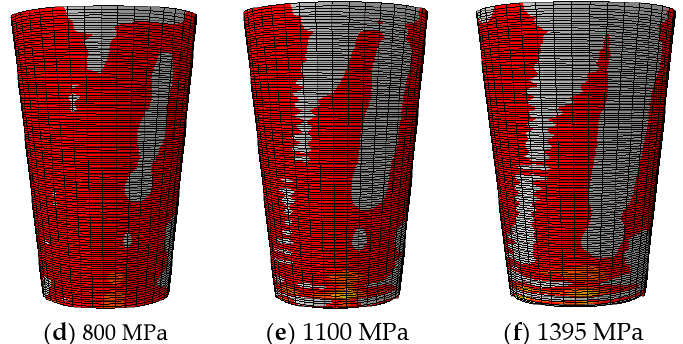
Figure 9. Contact area of the outer side of the wedge (gray surface).